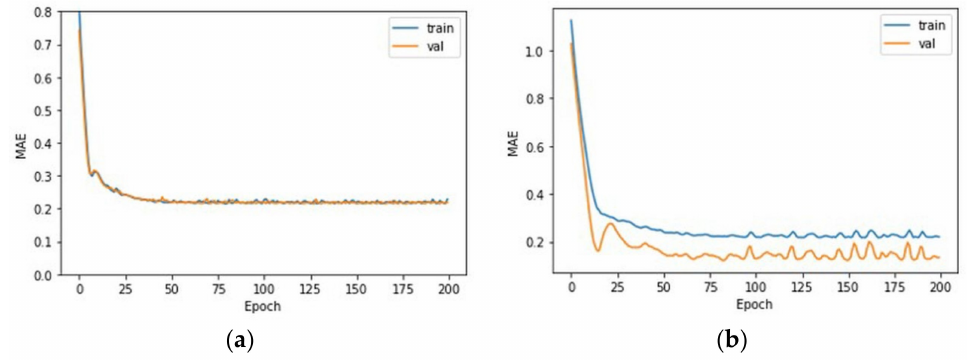
Figure 10. Outcome of selecting the best model and training it for 200 epochs. ( a ) An MAE result of 0.2172 was obtained based on the epoch for the condition of 1 to 20 processing times. ( b ) An MAE result of 0.1566 was obtained based on the epoch for the condition of 1 to 10 processing